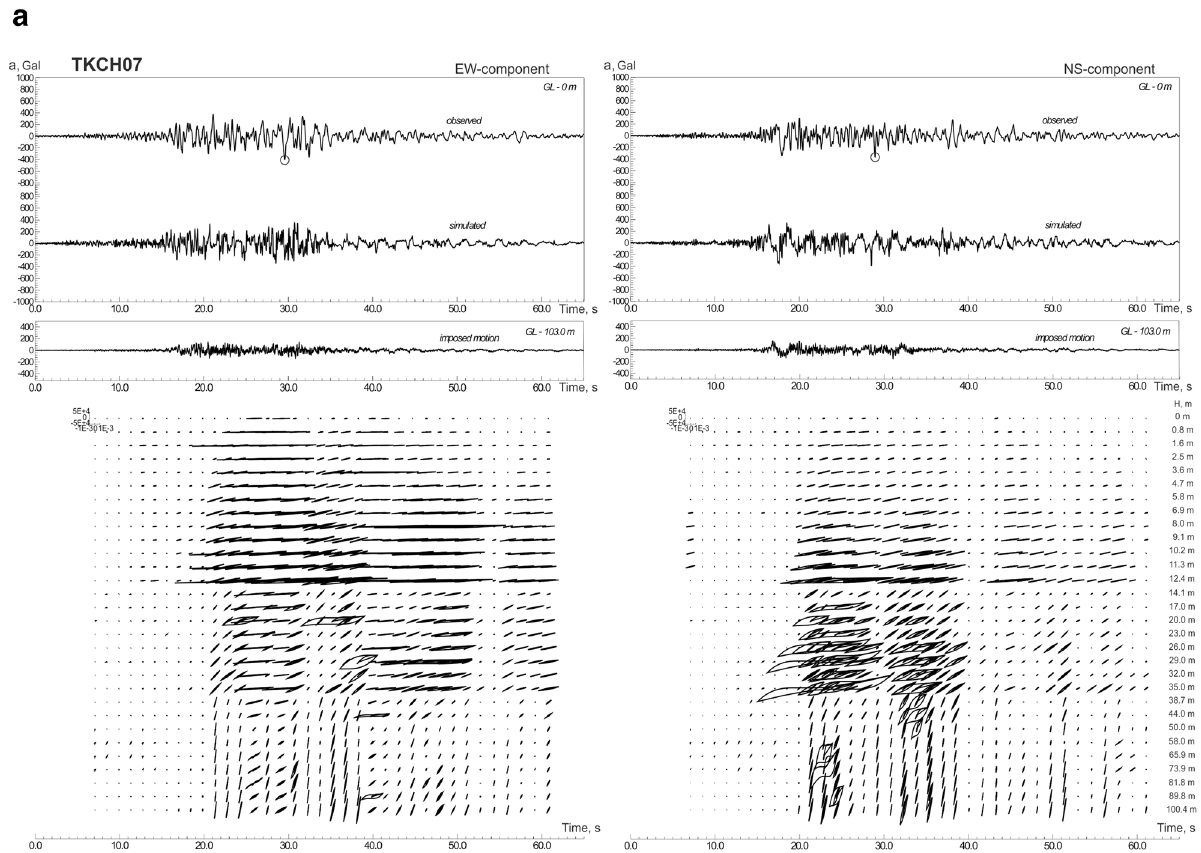
Figure 2. Acceleration time histories of the 2003 Tokachi-oki earthquake, observed and simulated, and estimated stress–strain relations in soil layers, changing with time during strong motion: ( a ) at TKCH07 site; ( b ) at KSRH03 site; ( c ) at KSRH10 site. Stresses are given in Pa, strains in strain. Peak ground accelerations are marked by small